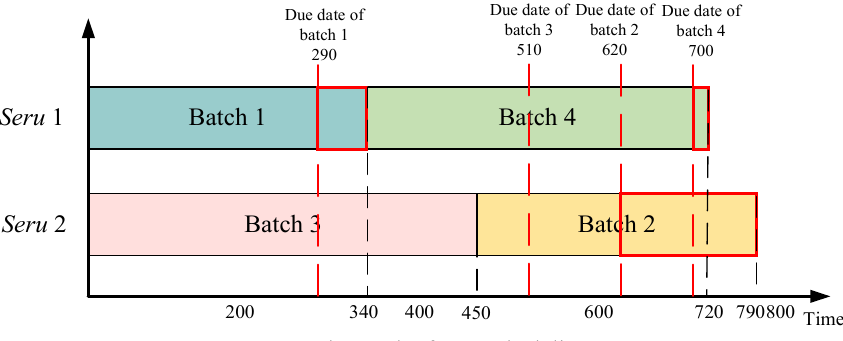
Fig. 2. The result of seru